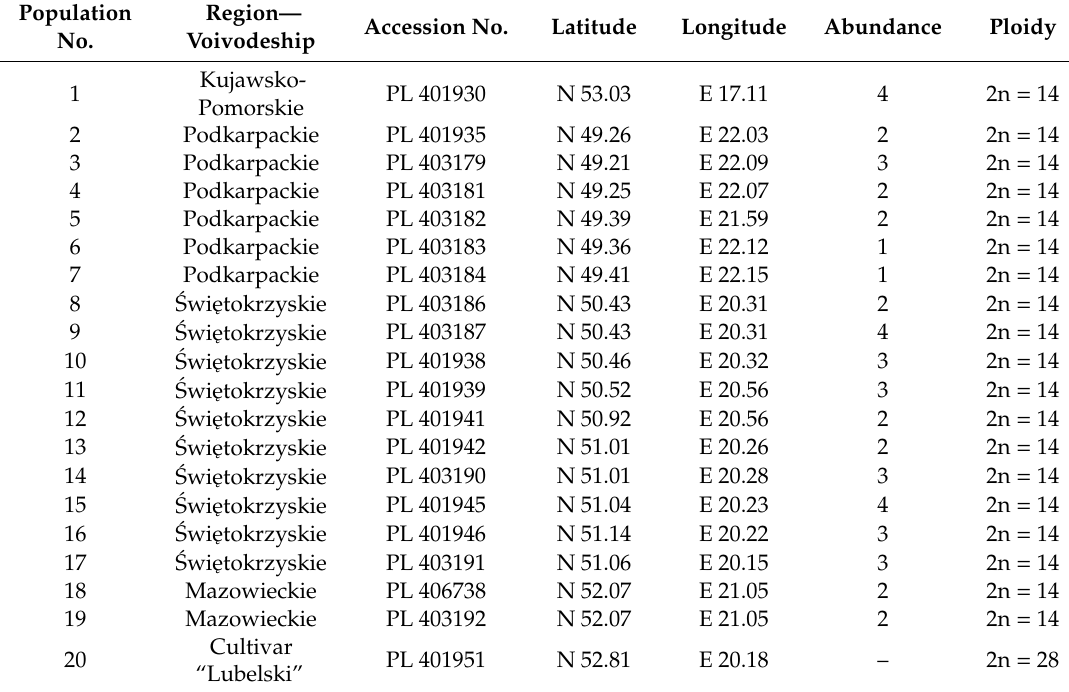
Figure 1. Geographical regions where the accessions of Valeriana officinalis originated from. Accession numbering in accordance with Table 1. Table 1. The list of surveyed accessions. The abundance according to the Braun-Blanquet scale. Accession number and passport data in accordance with the EGISET database of the National Centre for Plant Genetic Resources [20].